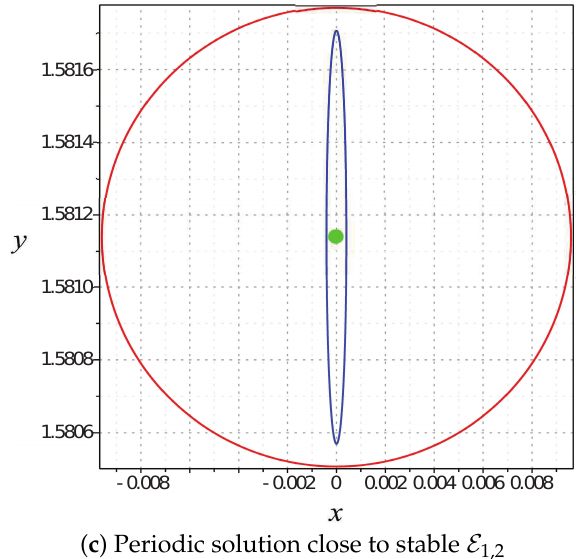
Figure 4. Periodic solutions close to the equilibrium points E 0 and E 1,2 . The green solid circle indicates the equilibrium